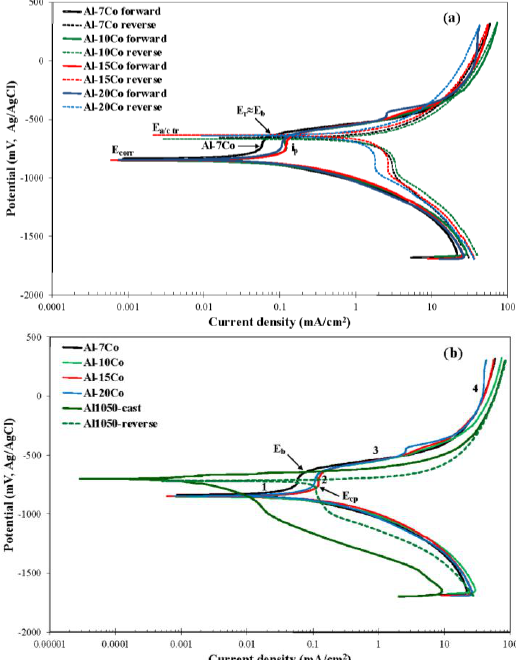
Figure 4. Potentiodynamic polarization behavior of the various alloys and CP-Al fabricated by casting of Al1050 sheet (Al1050-cast) in 3.5 wt.% NaCl, at 25 °C. ( a ) Al‐Co cyclic polarization; ( b ) Al‐Co forward polarization and CP‐Al cast cyclic polarization.